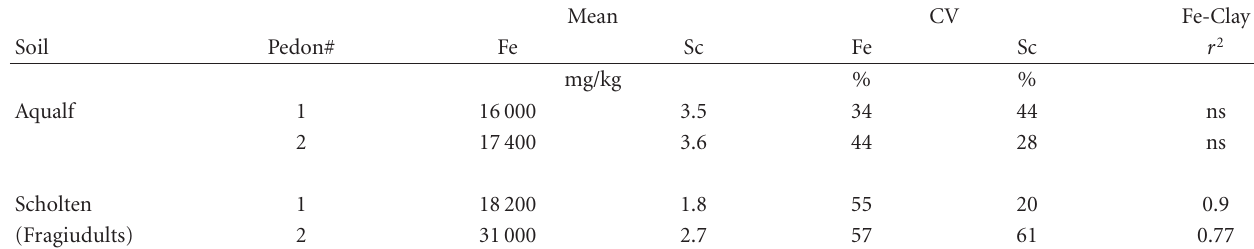
Table 2: Mean soil horizon Fe and Sc concentration